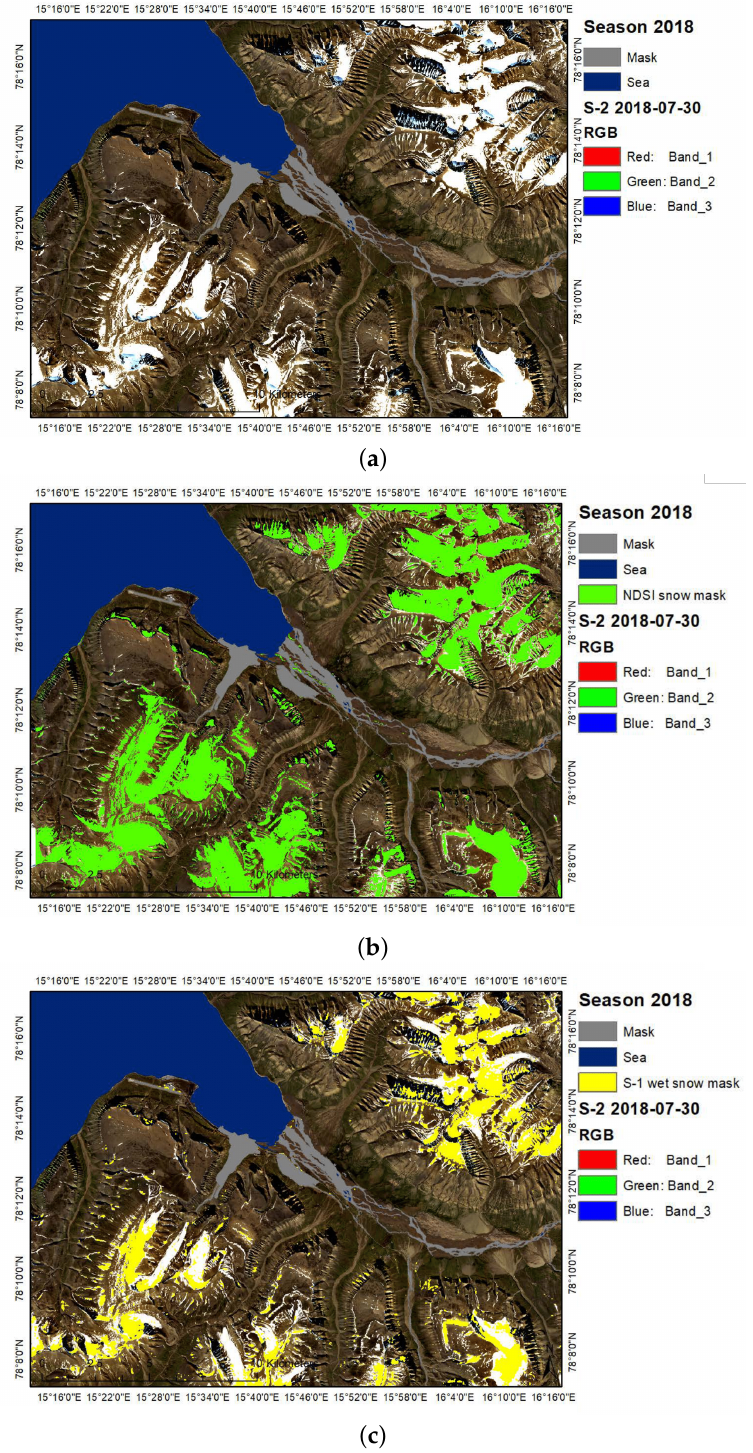
Figure 5. Sentinel-2 RGB images of 2018-07-30 ( a ) with overlapped in green the snow mask obtained using an NDSI threshold ( b ), and in yellow the wet snow mask obtained with 2.8 threshold on sigma 0 ( c